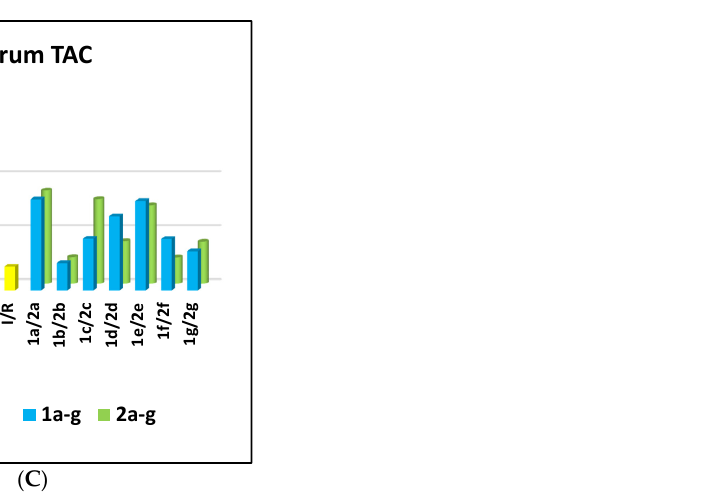
Figure 6. Concentrations of ( A ) serum epinephrine (ng/mg protein); ( B ) renal NOx (nmol/gm tissue); and ( C ) serum TAC (mmol/L) in the kidneys of I/R rats treated with cyclized thiadiazols derivatives 2a – g and their corresponding opened hydrazinecarbothioamides 1a – g in comparison with NAC (reference).